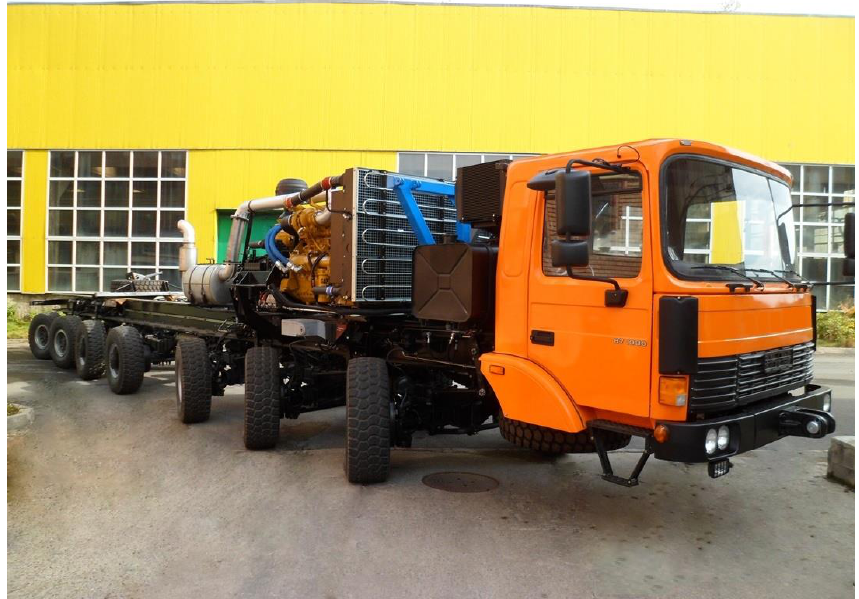
Figure 1. The truck with one chassis and two engines.